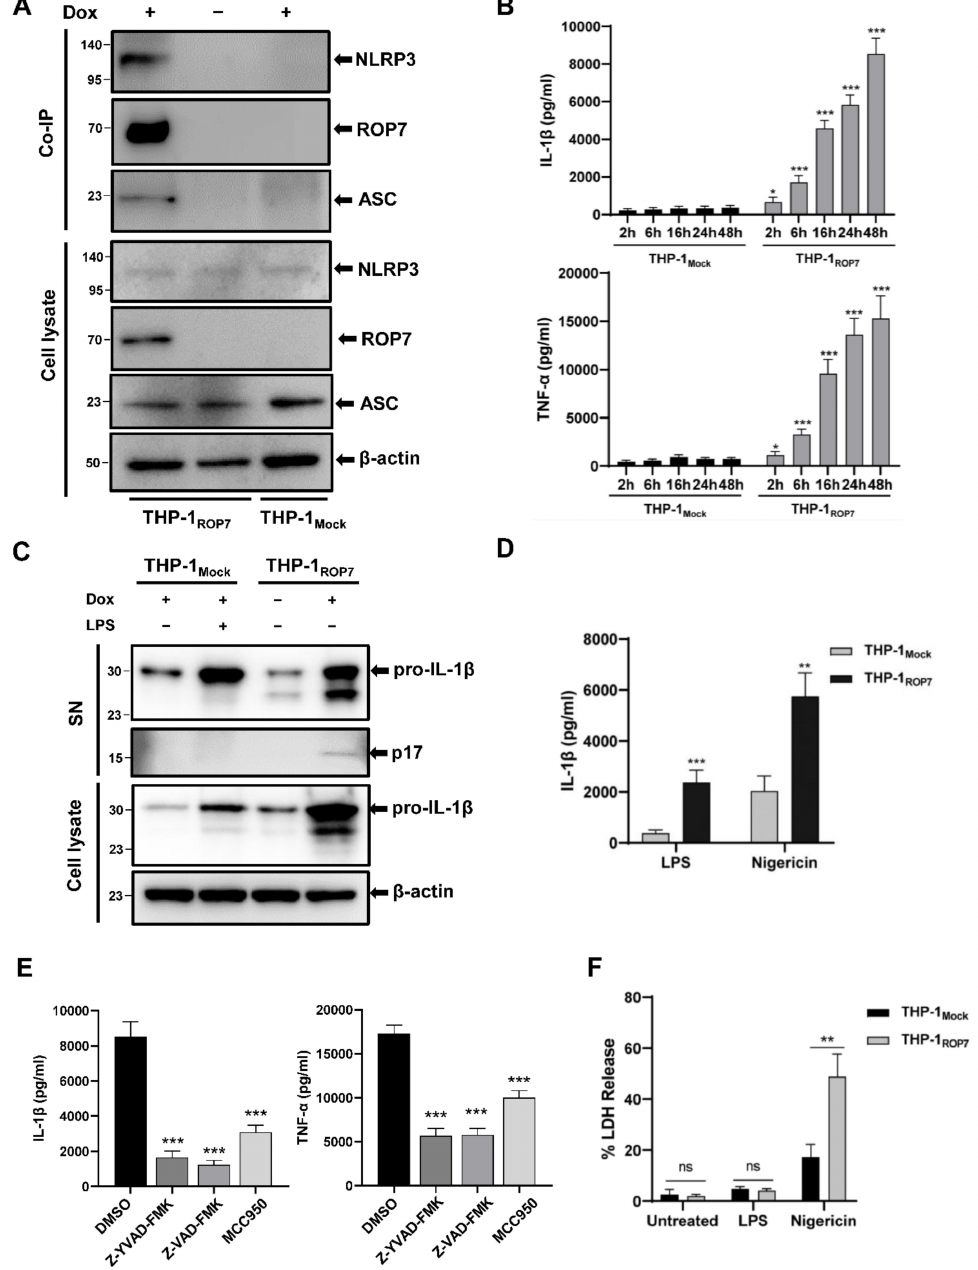
Figure 3. ROP7 in THP-1 cells activated NLRP3 inflammasome and induced a hyperactive status